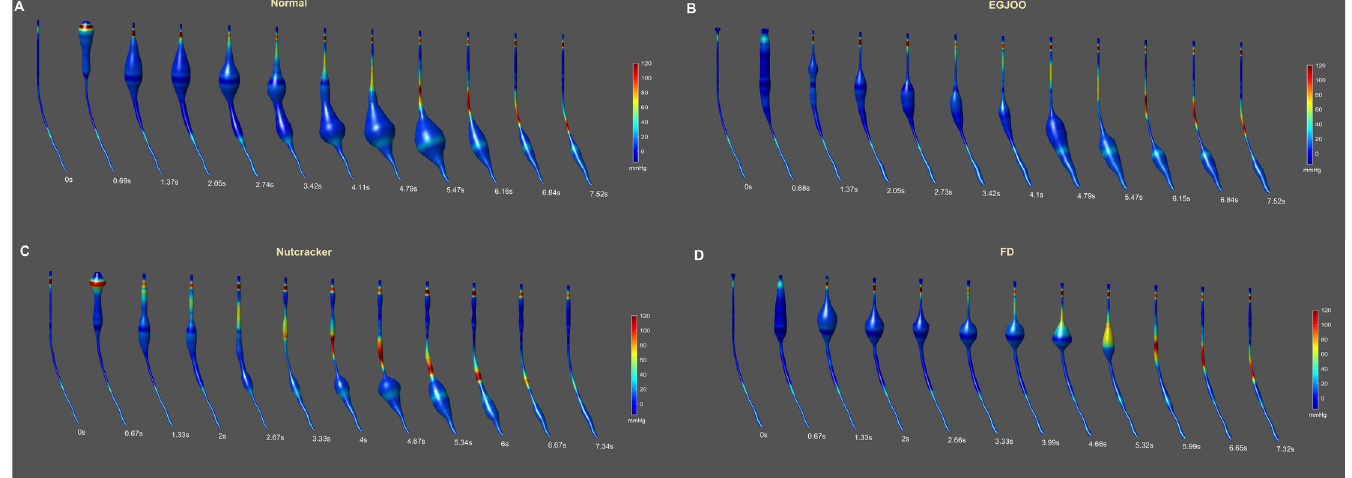
Fig 3. Schematic of distension contraction patterns along the length of the esophagus in, (A) normal subject, (B) patient with esophagogastric junction outflow obstruction (EGJOO), (C) patient with nutcracker esophagus (NC), and (D) patient with functional dysphagia. (same swallows from Figs 1 and 2). Note, that the amplitude of distension in patients is smaller and there is alteration in the temporal relationship between distension and contraction